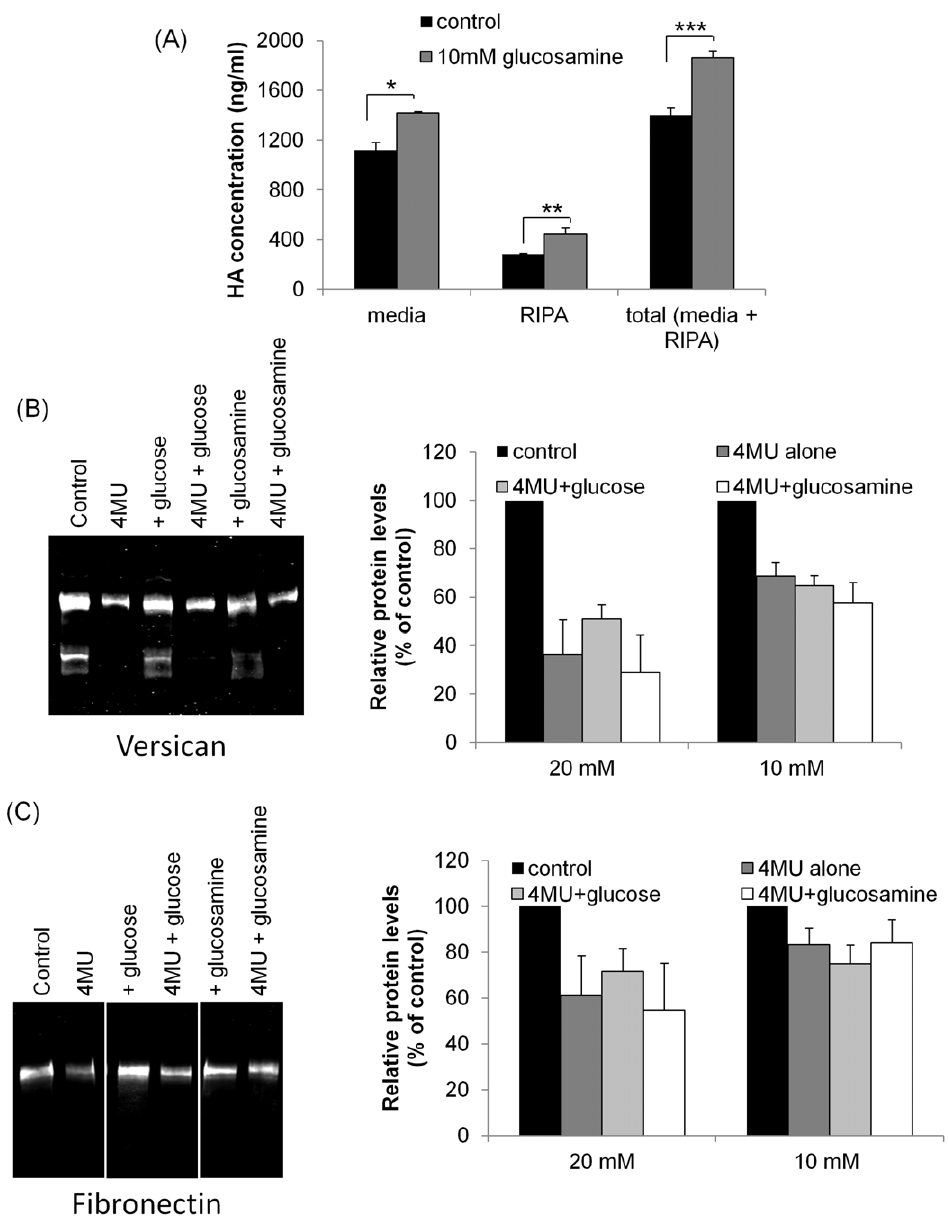
Figure 4. Effect of addition of glucose and glucosamine to 4MU-treated TM cells. (A) An HA ELISA assay was used to quantitate HA levels in TM cells treated with 10 mM glucosamine for 48 hrs. HA levels were significantly increased in media (*p=0.008), RIPA lysates (**p=0.04) and total media + RIPA lysates (***p=0.004) compared to untreated control TM cells. Error bars are the s.e.m; n=3. (B, C) Confluent TM cells were treated for 4 days with 1 mM 4MU alone, or 4MU with 10 mM glucose or 10 mM glucosamine in serum-free media. Versican and fibronectin protein levels in conditioned media were assessed by Western immunoblot. (B) Versican V1 isoform and (C) fibronectin protein levels were significantly decreased by 4MU treatment. Addition of 20 mM or 10 mM glucose or glucosamine did not significantly alter protein levels compared to 4MU treatment with either glucose or glucosamine supplementation. The Western immunoblots show data from a 10 mM treatment. For the versican immunoblot, all lanes were from adjacent lanes of the same immunoblot. The fibronectin immunoblot shows non-adjacent lanes from the same immunoblot. Versican and fibronectin values were normalized to total protein loaded and are presented as a percentage of the control. Error bars are the s.e.m.; n=3. HA detected in the outer beams and inner wall, while the pattern ular to Schlemm’s canal, a pattern similar to that observed of staining in the JCT was reduced and became more punctate previously. [28] HAbp staining showed good colocalization with (Fig. 6B, H). Versican immunostaining in control eyes was versican in control TM (Fig. 6E). In 4MU-treated tissue, overall abundant in the JCT region, with less staining in the outer beams levels of versican immunostaining were reduced and the staining and in the outer wall of Schlemm’s canal (Fig. 6C). Versican pattern was altered, especially in the JCT region (Fig. 6D). In these immunostaining was in pillar-like structures that run perpendic- eyes, punctate HAbp staining did not colocalize with versican